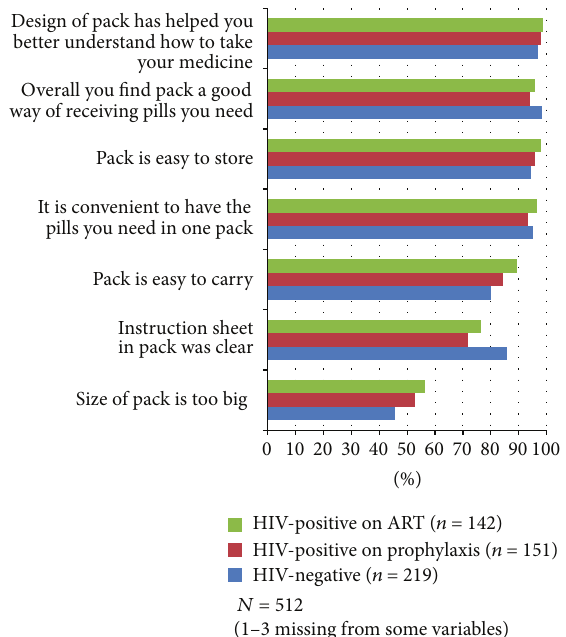
Figure 3: Percentage of structured interview participants that agree with the copackage feasibility statements by HIV status